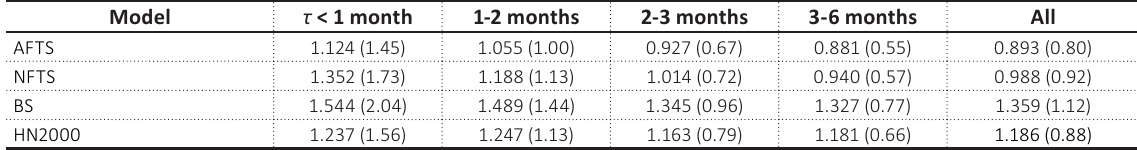
Table 3. Out-of-sample forecast errors as a function of the